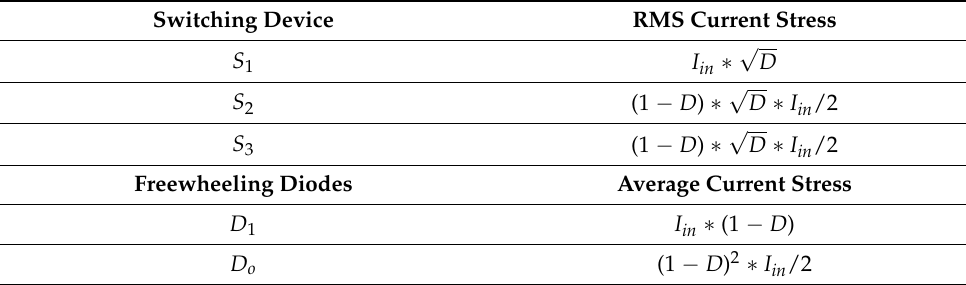
Table 2. The current stresses of the switching devices.